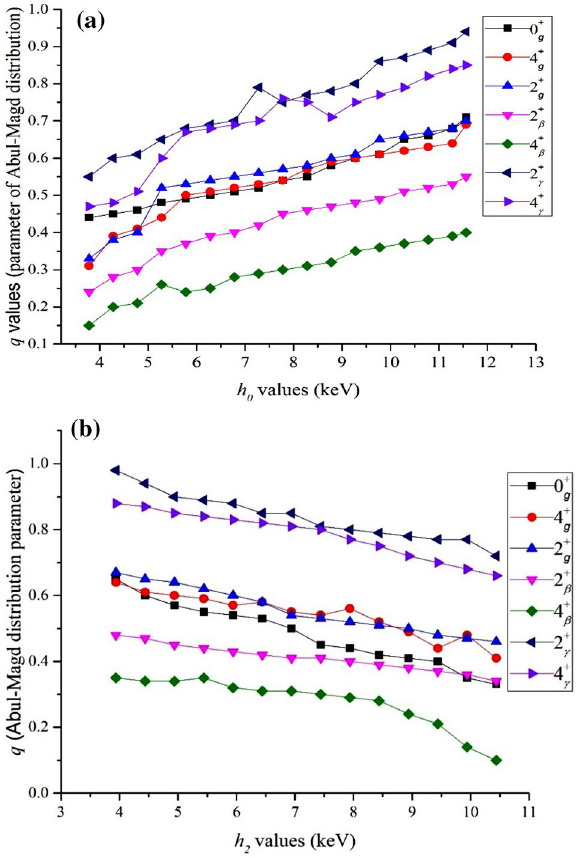
Figure 1. The variation of chaoticity degree, q values, for energy levels of considered nuclei determined by using ( a ) different h 0 ( b ) different h 2 values in the PDS